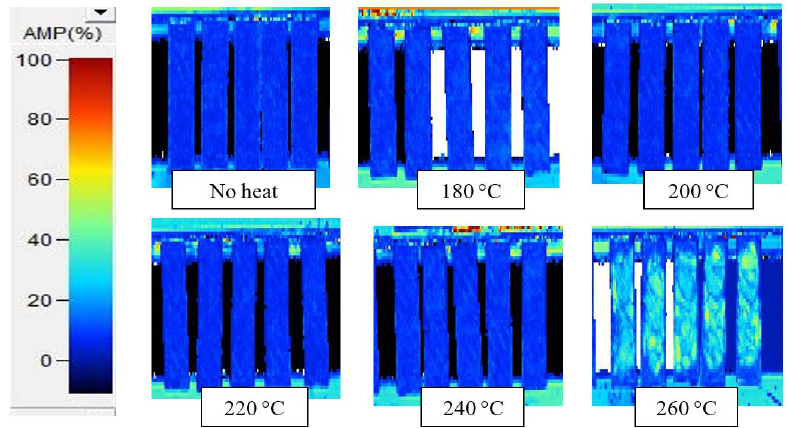
Figure A7. C ‐ scans of samples after 10 min thermal exposures, using amplitude of maximum interior echo.